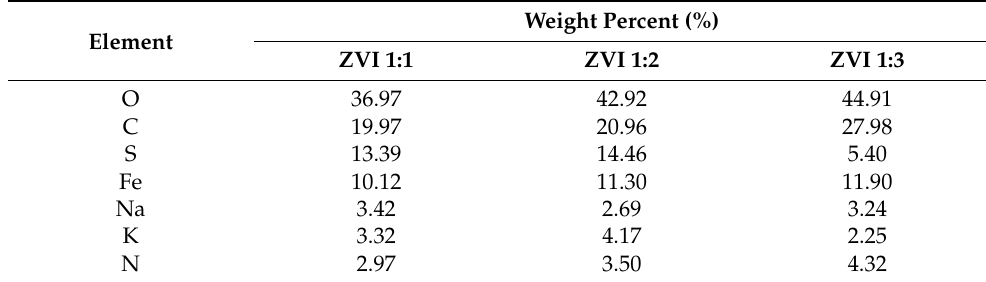
Figure 7. SEM images of: ( a ) ZVI 1:1; ( b ) ZVI 1:2; and ( c ) ZVI 1:3. Table 2. Weight percent of EDS measurement results for ZVI 1:1, 1:2, and